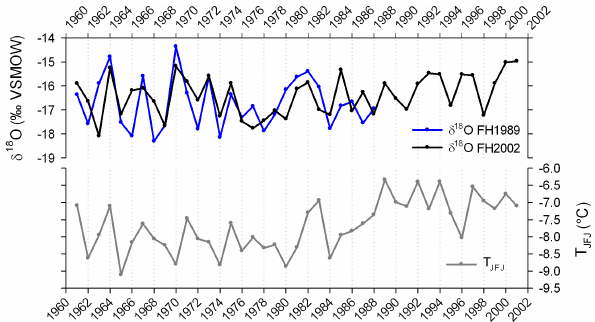
Figure 5. Annual δ 18 O from FH2002 ice core (black), FH1989 (blue), together with the annual mean temperature at the Jungfrau- joch weather station